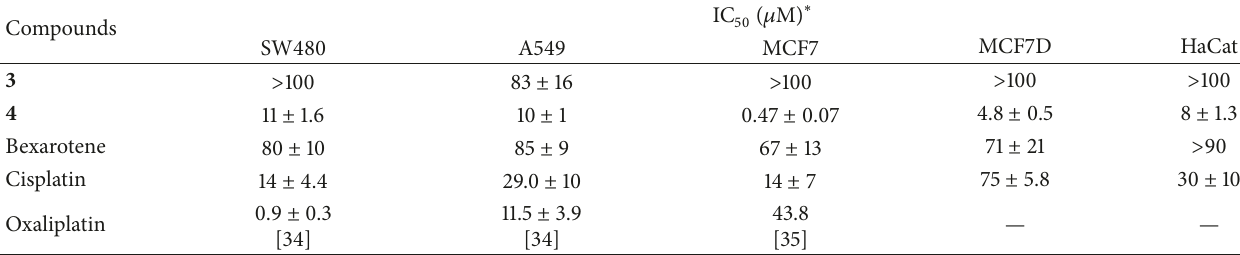
Table 1: Cytotoxicity of new complexes, bexarotene, cisplatin, and oxaliplatin.